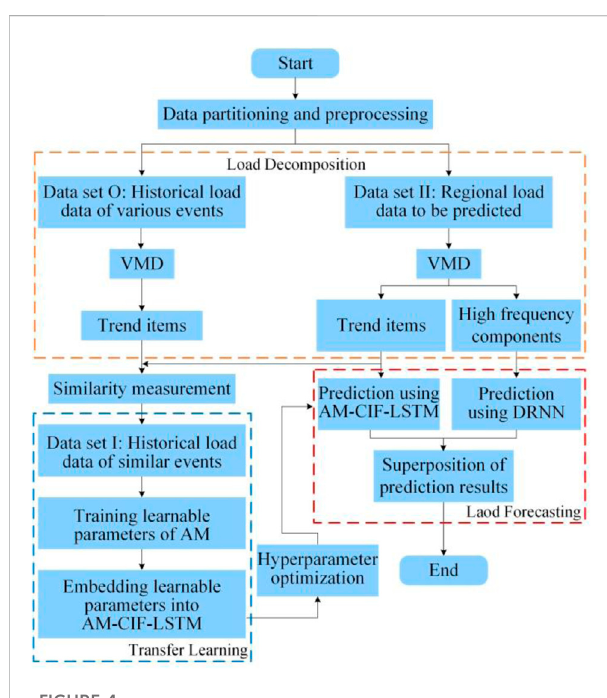
FIGURE 4 Flow chart of solving steps for the proposed load forecasting